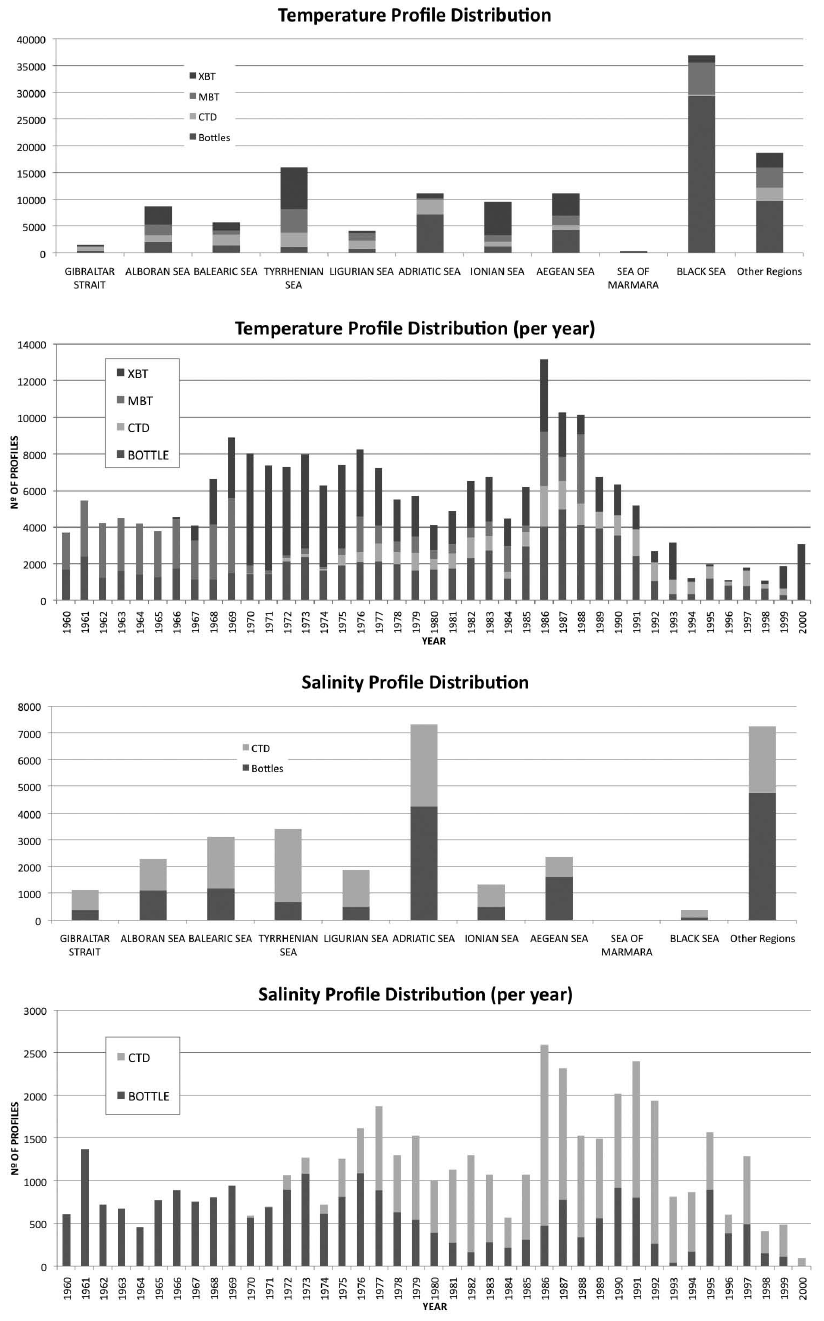
Fig . 1. – MEDAR spatial and temporal profile